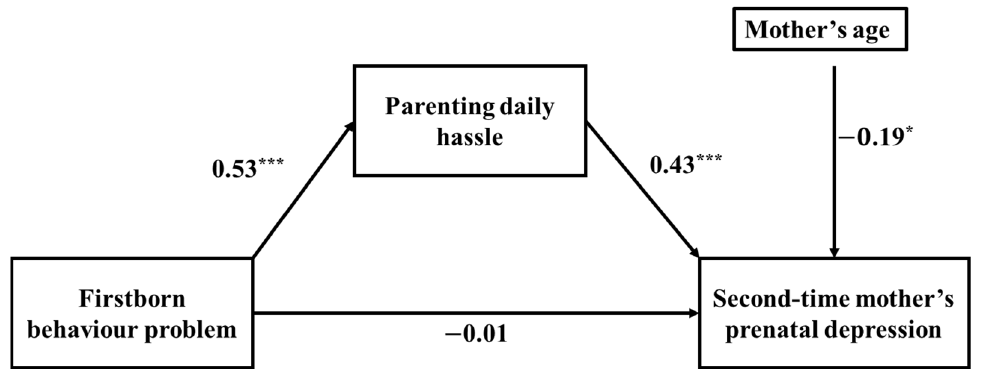
Figure 2. Standardized regression coefficients for the relationship between firstborn’s behaviour problems and second-time mother’s prenatal depression mediated by parenting daily hassle. * p < 0.05, *** p < 0.001.